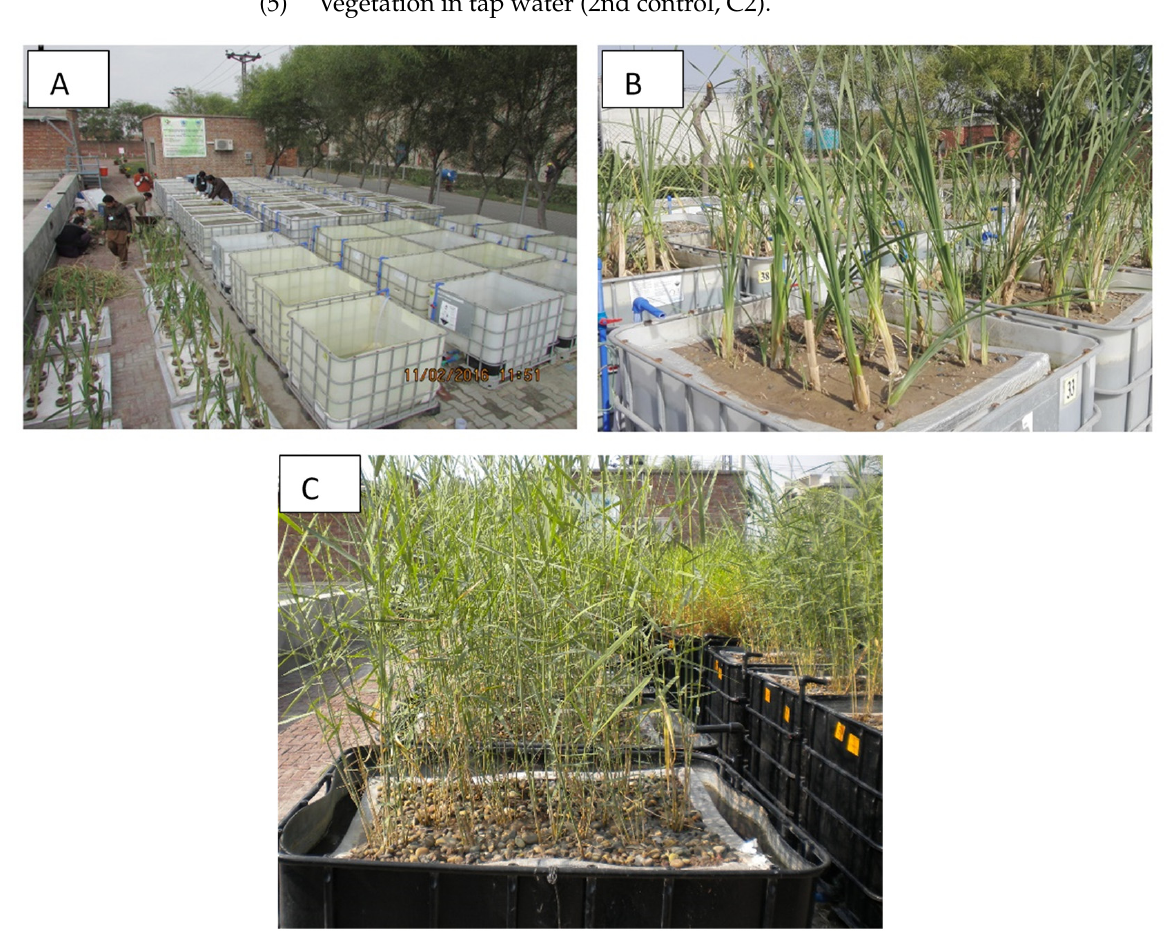
Figure 1. The development and installation of FTW macrocosms with Typha domingensis ( A , B ), and Phragmites australis ( C ).